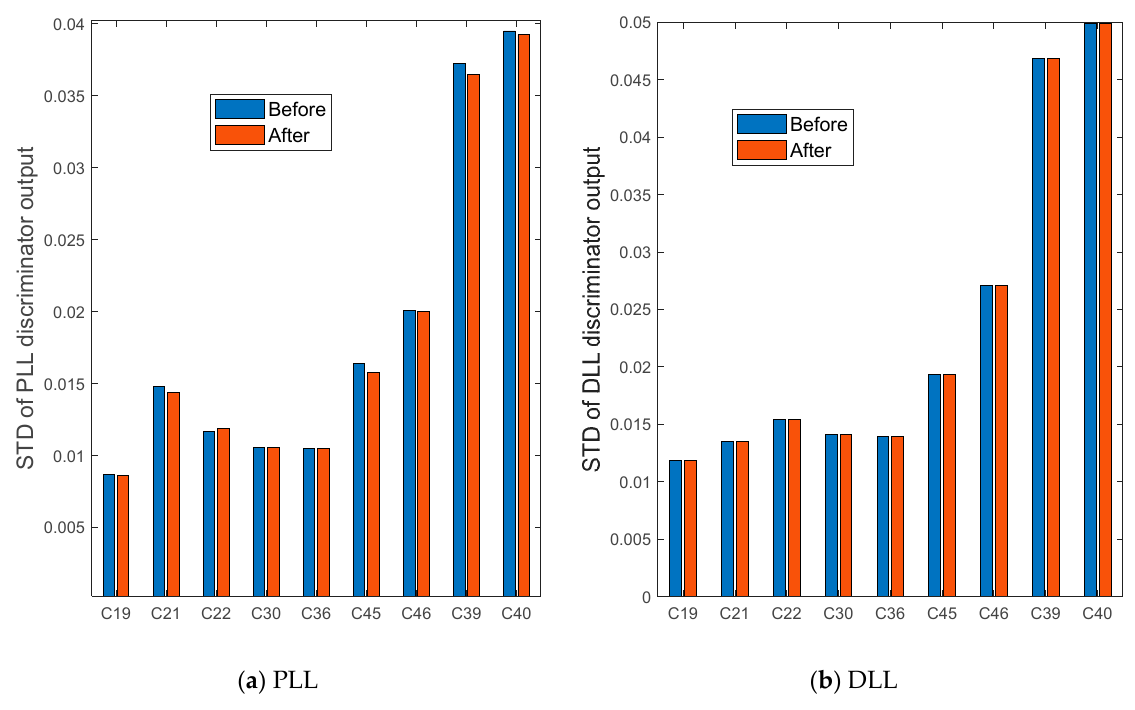
Figure 23. Standard deviation of loop output before and after phase bias correction for B2a and B2b signal.